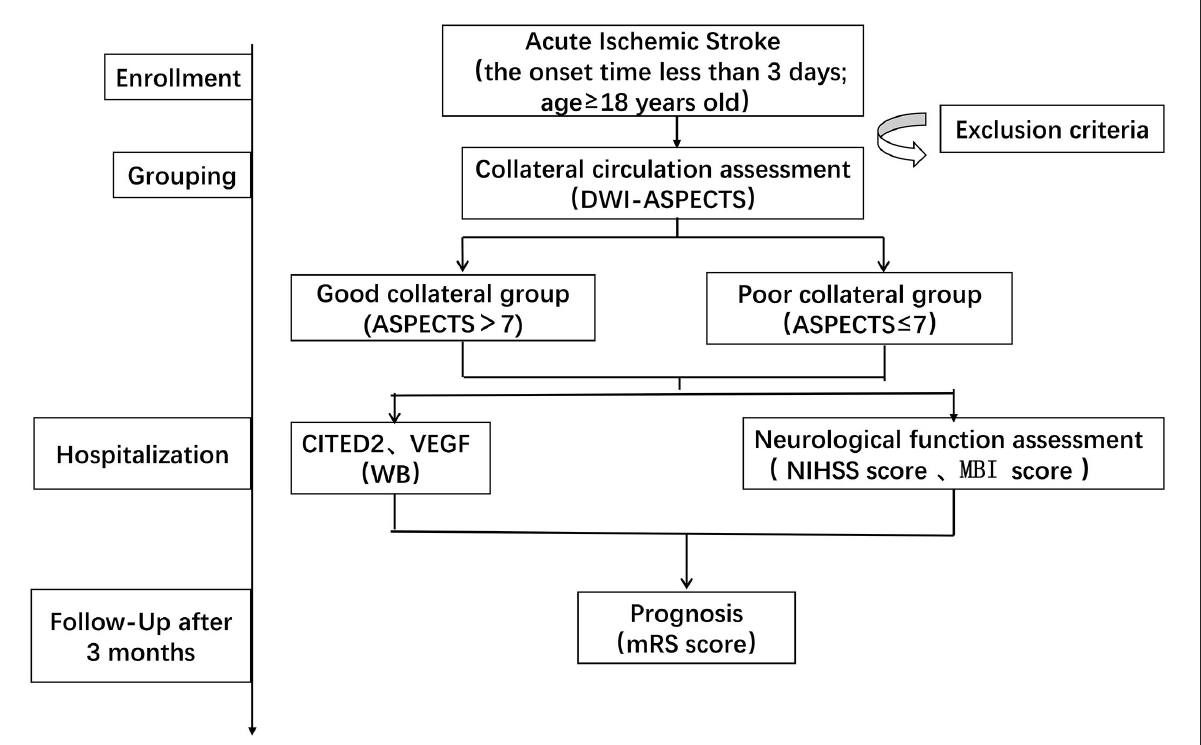
FIGURE1 Schedule of enrollment and assessments. DWI-ASPECTS, diffusion weight image–Alberta Stroke Program Early CT Score; CITED2, CBP/P300-interacting transactivator with Glu/Asp-rich C-terminal domain 2; VEGF, vascular endothelial growth factor; WB, Western blot; NIHSS, National Institute of Health Stroke Scale; MBI, Modified Barthel Index; mRS, Modified Rankin